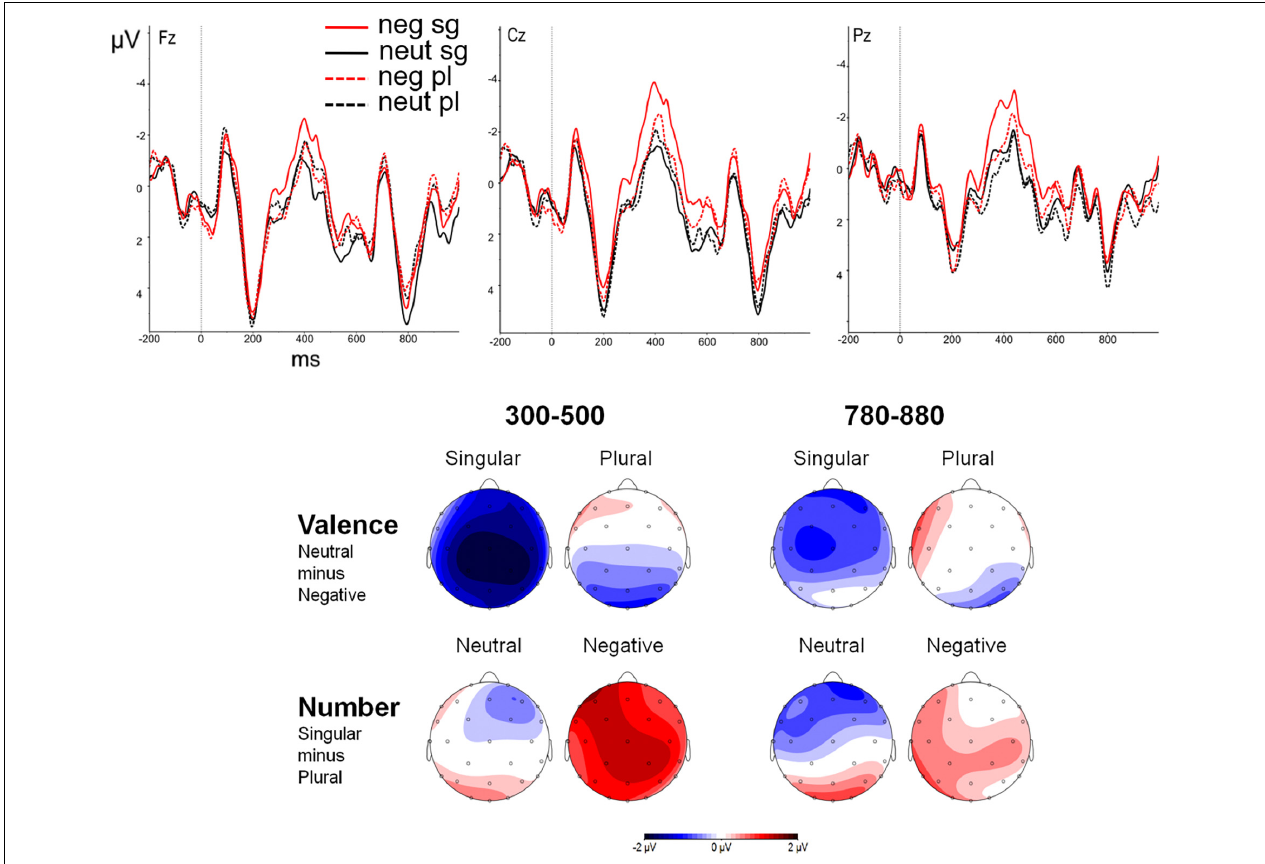
FIGURE 1 | Event-Related Potentials (ERPs) to valence and number manipulations at the three midline electrodes (Fz, Cz, and Pz) and topographic maps in the attractor (local noun) position in 300–500 and 780–880 ms